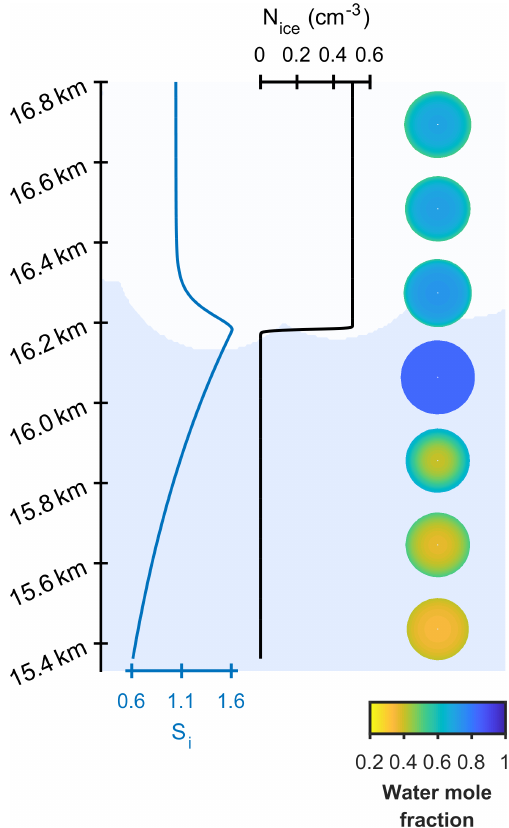
Figure 7. A schematic showing the changing aerosol particle mor- phology after homogeneous ice